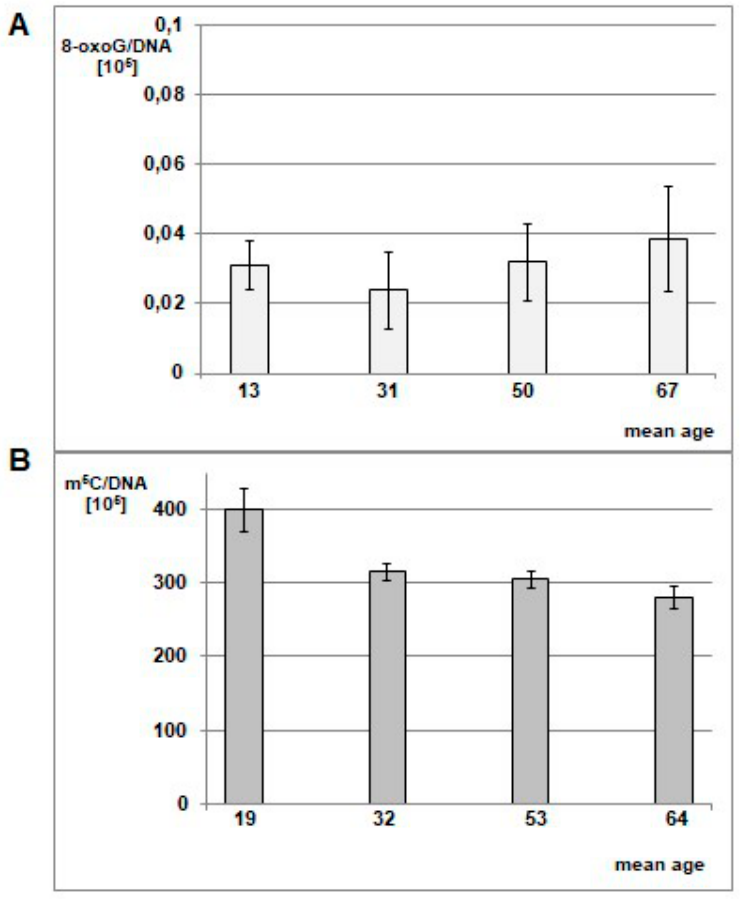
Figure 6. Mean level of 8-oxo-dG ( A ) in leukocyte DNA in healthy individuals cohort divided into mean age groups of 13, 31, 50, and 67 y.o. The graph was prepared based on data taken from Siomek et al. 2007 [30], 8-oxo-dG values were recalculated per genome. One can see the minute amounts of 8-oxo-dG in healthy subjects. ( B ) Mean amount of m 5 C in DNA from peripheral blood samples of healthy individuals in di ff erent age groups. The cohort (Table S3) was divided into 4 age groups: < 21 y.o. (mean age 19), 21–40 y.o. (mean age 32), 41–60 y.o. (mean age 53), > 60 y.o. (mean age 64). The amounts of m 5 C were significantly higher than in glioma patients.